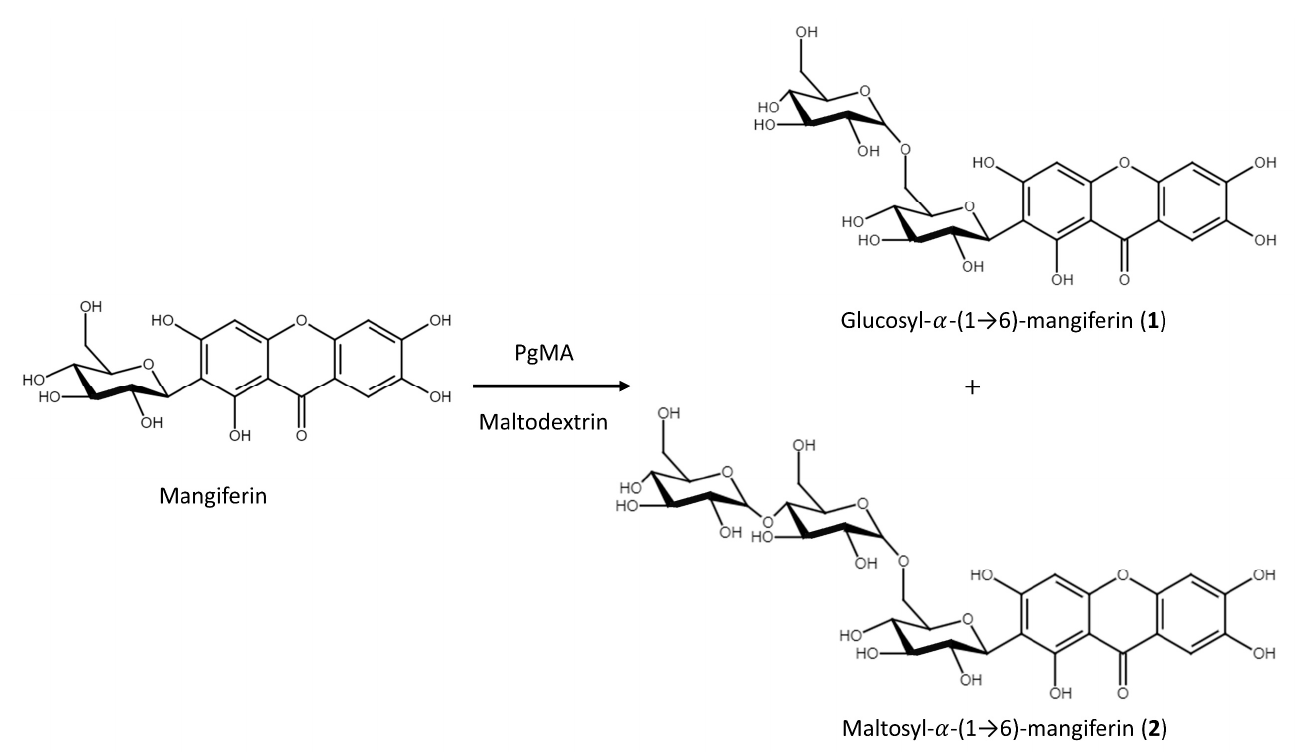
Figure 8. Biotransformation process of mangiferin by Pg MA. Table 1. Aqueous solubility of mangiferin and maltosyl- α -(1 → 6)-mangiferin ( 2 ).